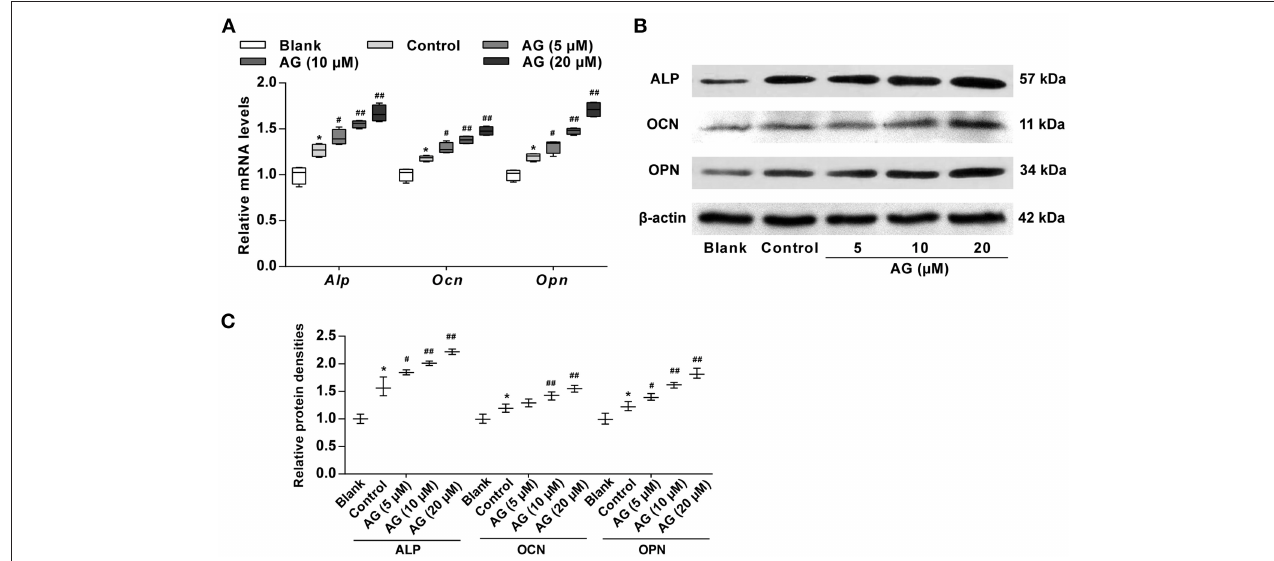
FIGURE 2 | The effects of AG on the expression of osteoblastic marker genes in mouse MC3T3-E1 cells. (A) Quantitative analysis of the mRNA levels of Alp , Ocn , and Opn in MC3T3-E1 cells after treatment with AG for 7 days was determined by RT-qPCR. N = 4. (B) The protein levels of ALP, OCN, and OPN in MC3T3-E1 cells after treatment with AG for 7 days were measured by western blot. (C) Quantitative analysis of the protein level of ALP, OCN, and OPN in MC3T3-E1 cells after treatment with AG for 7 days. N = 3. All of the data are shown as the mean ± S.D. of the independent experiments. * P < 0.05 compared with the corresponding blank group. # P < 0.05, ## P < 0.01 compared with the corresponding control group.